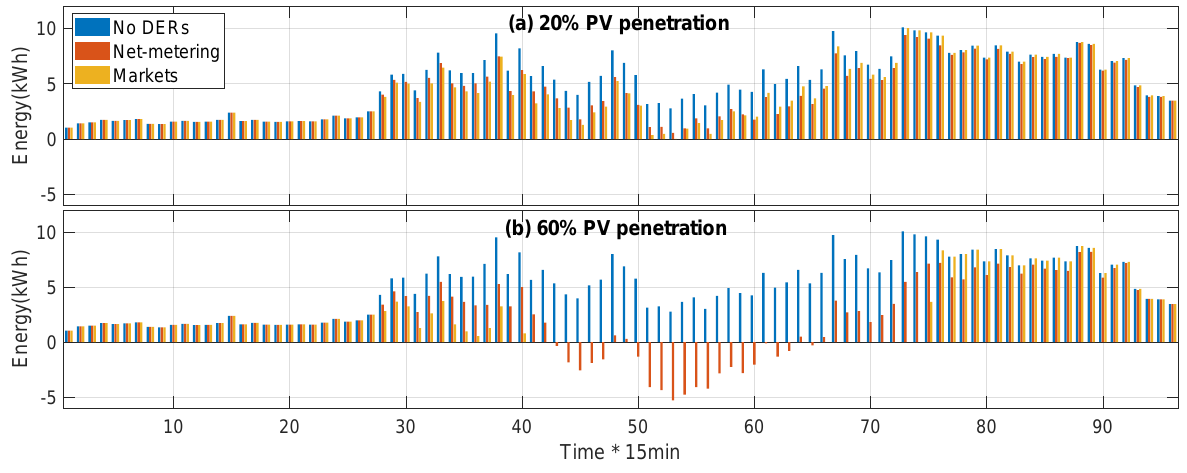
Figure 12. Energy balance, which will be required by the utility as a sum of all agents loads, PVs and storage systems at ( a ) 20% PV Penetration; ( b ) 60% PV